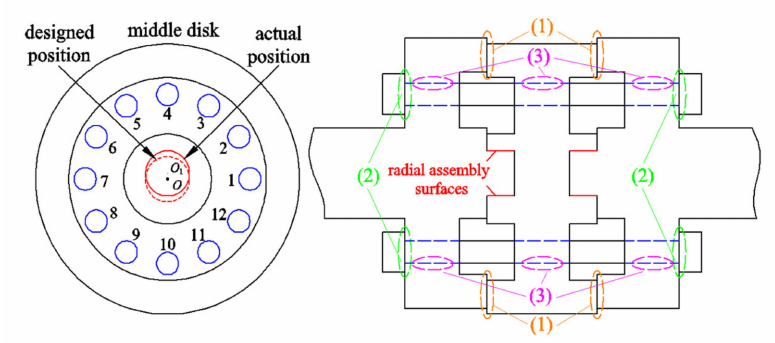
Figure 2. Formation of inner misalignment and concomitant interfaces between disks.